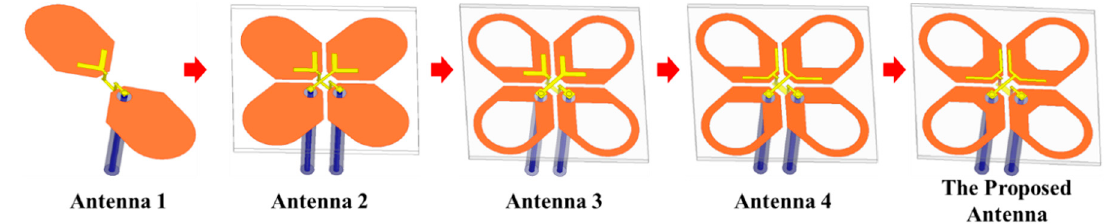
Figure 2. Evolution of antenna structure.